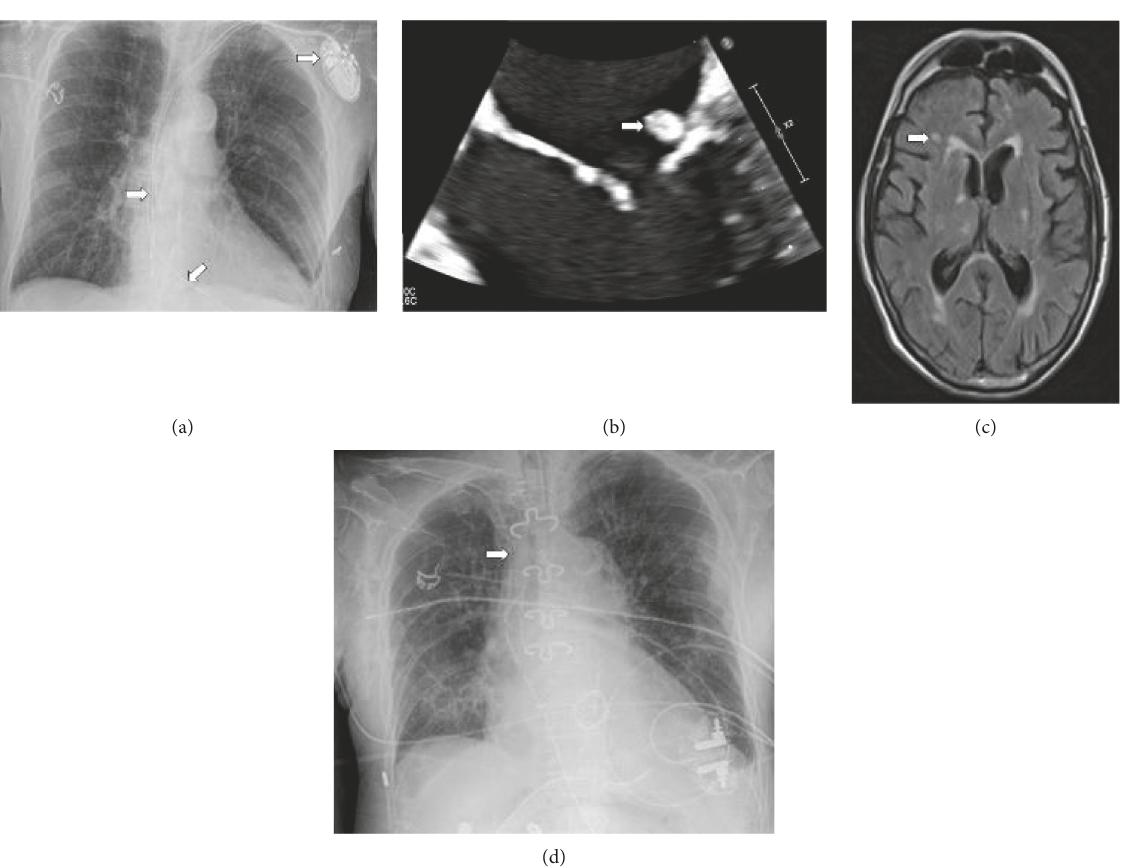
Figure 1: (a) Chest radiography with implanted pacemaker, (b) transesophagal echography, (c) MRI cerebral showed the emboli, and (d) chest radiography with external